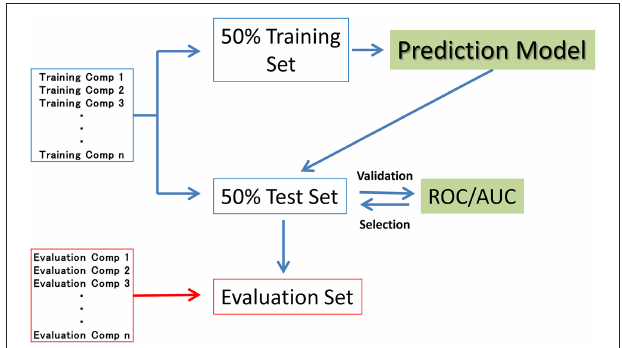
FIGURE 1 | Datasets used in model